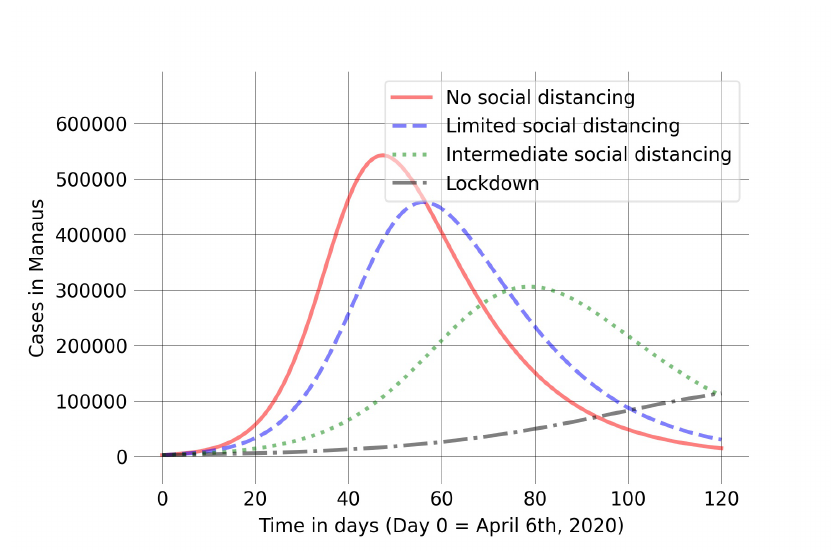
Figure 2. Controlling the contact rate – 120 days